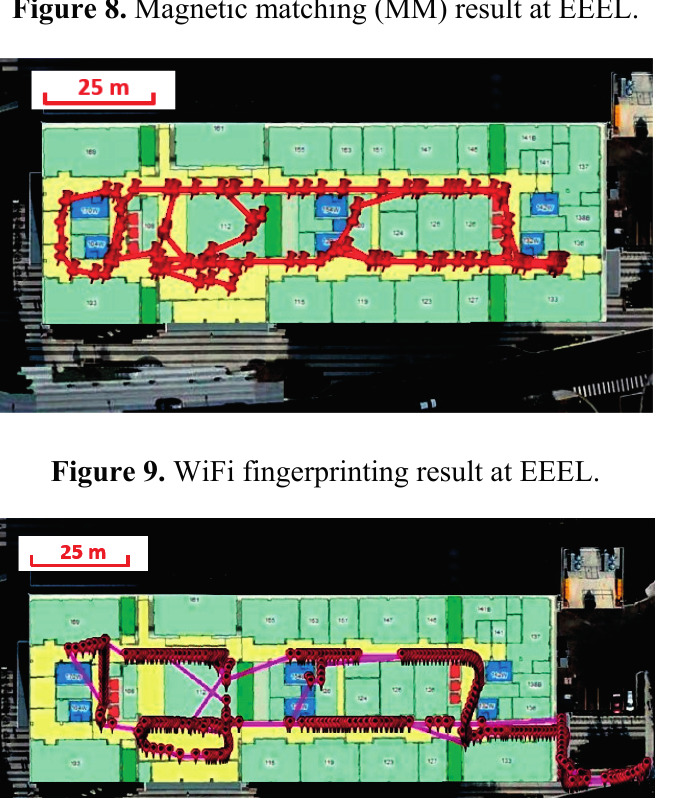
Figure 8. Magnetic matching (MM) result at EEEL.